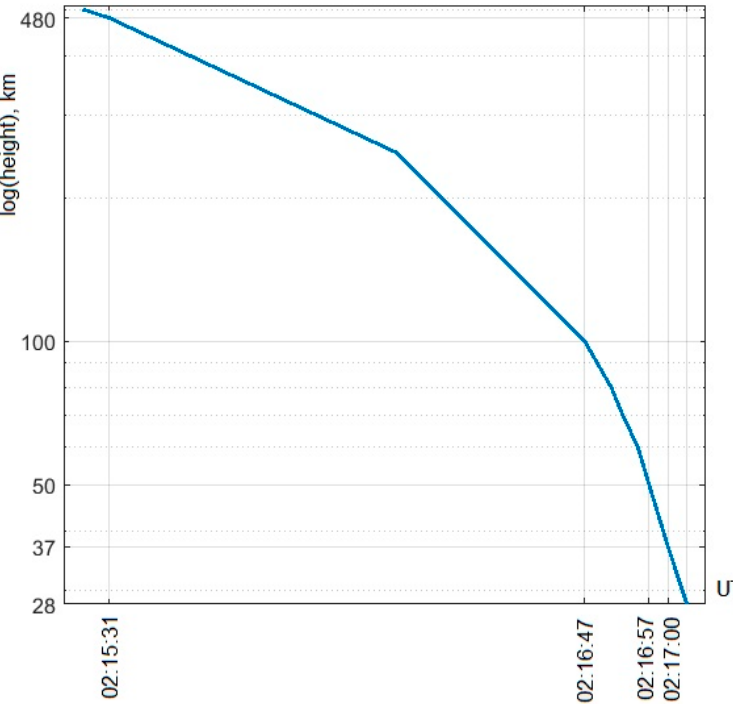
Figure 7. Reconstructed meteoroid oblique path in time.